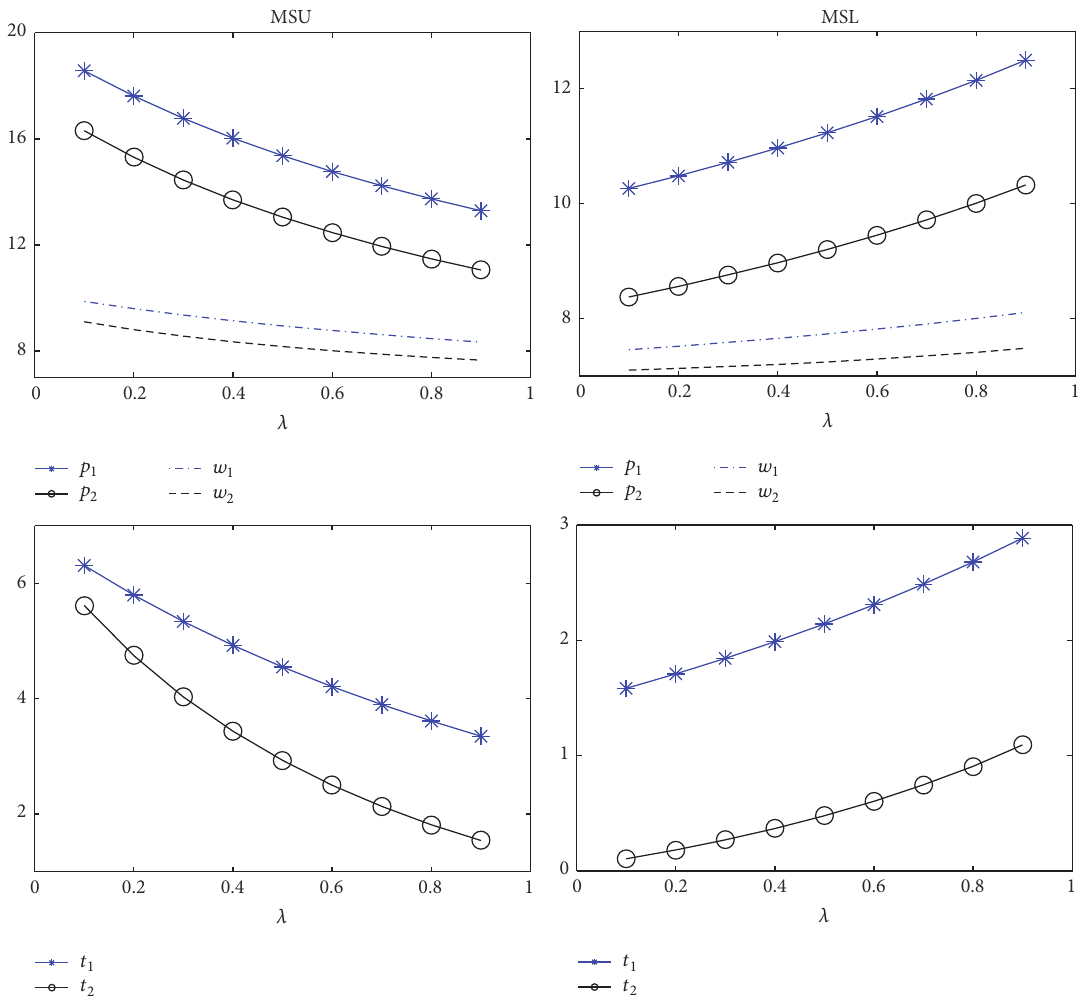
Figure 1: Changes of prices and warranty levels with 𝜆 in MSU and MSL model.